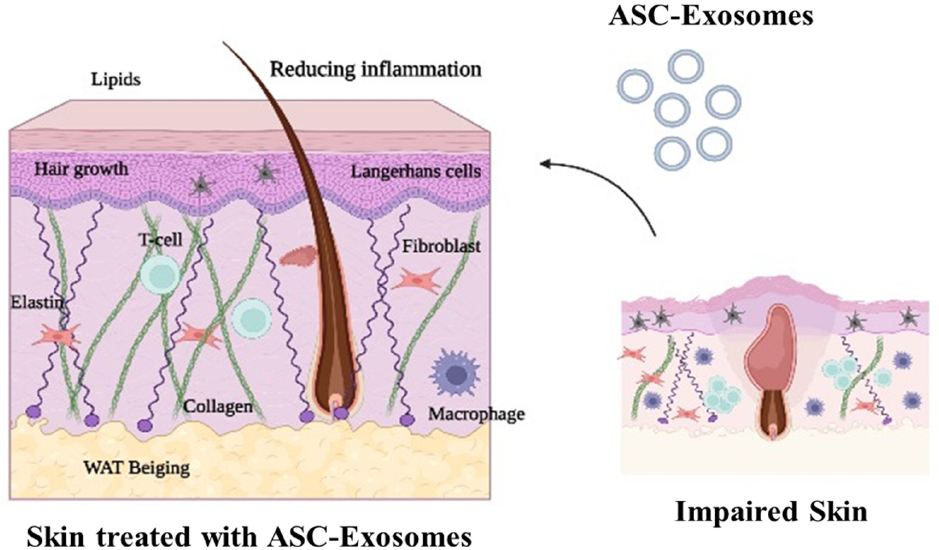
Figure 2. Therapeutic role of adipose-derived stem cells (ASC-exosomes) in aberrant skin conditions. Exosomes released from ASC-exosomes have been found to have regenerative and anti-inflammatory effects on the skin, helping to improve its appearance and texture. These exosomes are thought to reduce wrinkles and pigmentation, as well as promote collagen production. Figure was created using